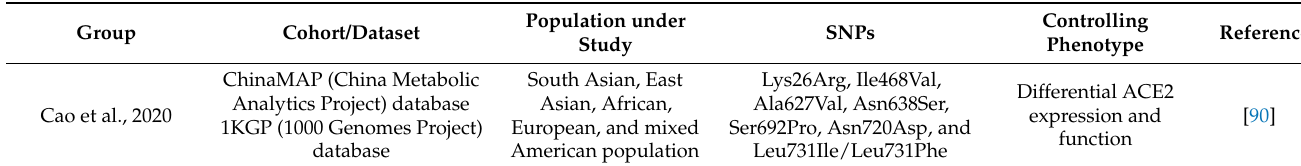
Table 2. SNPs detected in genetic locus encoding for